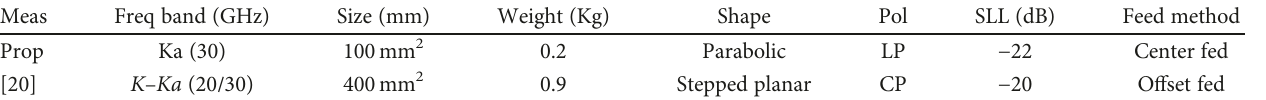
Table 2: The performance comparison of the proposed 3D printed re fl ector antenna with the previous published in [20]. Meas Freq band (GHz) Size (mm)